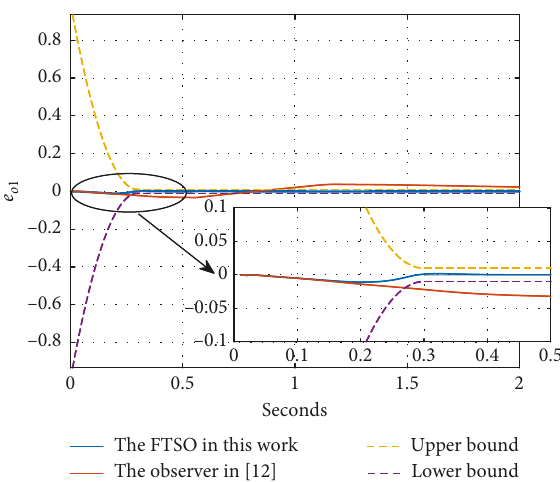
Figure 3: The observer compared results of e